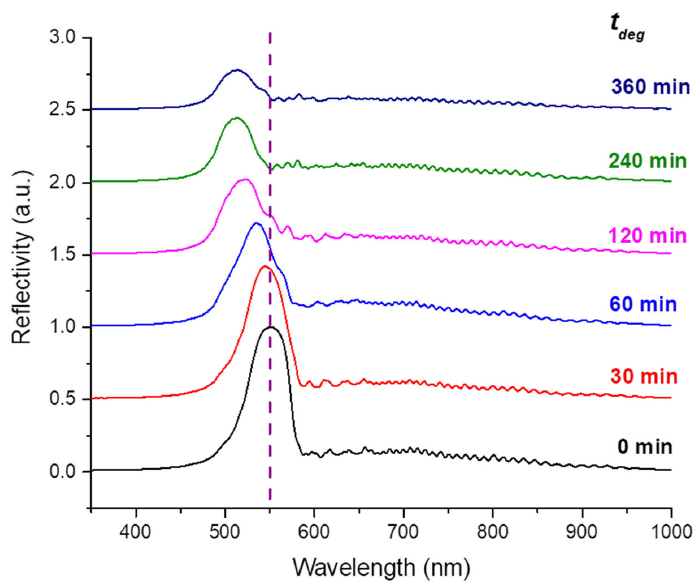
Figure 4. RIfS spectra of PLA coated pSiRF after incubation with 1.00 mg mL − 1 proteinase K for 0, 30, 60, 120, 240 and 360 min. The RIfS measurement was performed after the washing and drying steps of pSiRF.